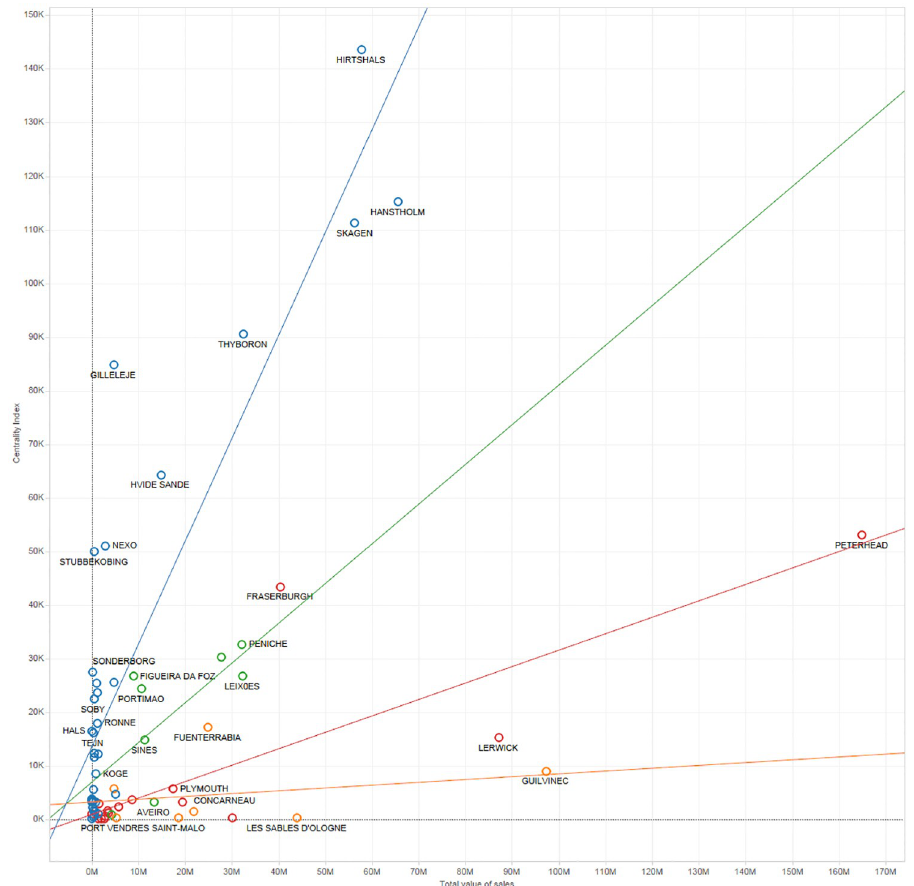
Fig 3. Relation between the centrality score of ports and the average annual value of fish sales in fish markets in the same location. Lines show simple linear regressions to data points from individual countries, blue: Denmark; green: Portugal; red: UK; orange: